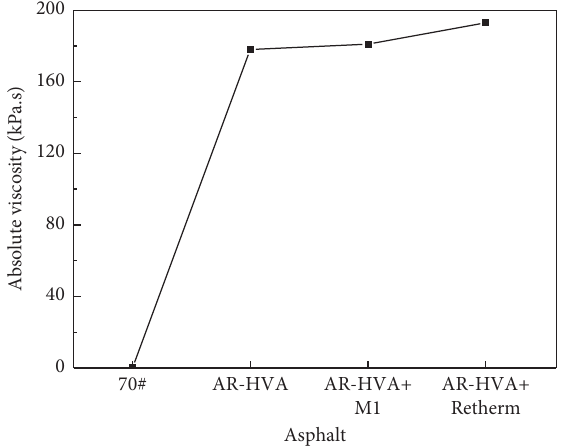
Figure 4: Absolute viscosity of different asphalts. Table 2: Fitting equations for the viscosity-temperature curves of different asphalts. Asphalt species